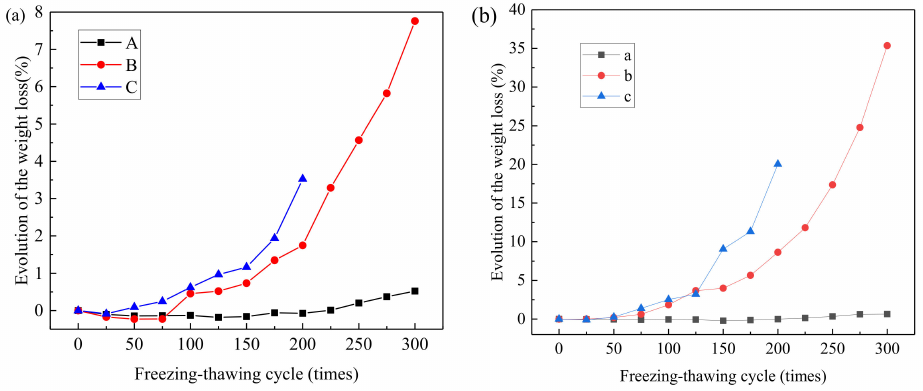
Figure 3. Mass loss rates of concretes: ( a ) prismoid specimens; ( b ) cube